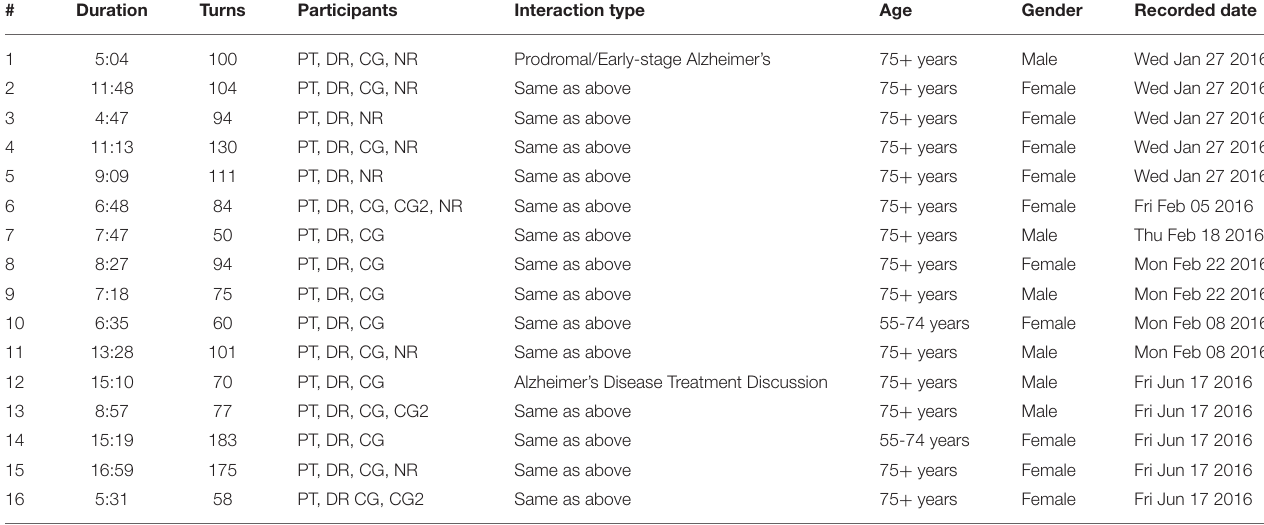
TABLE 2 | Participant